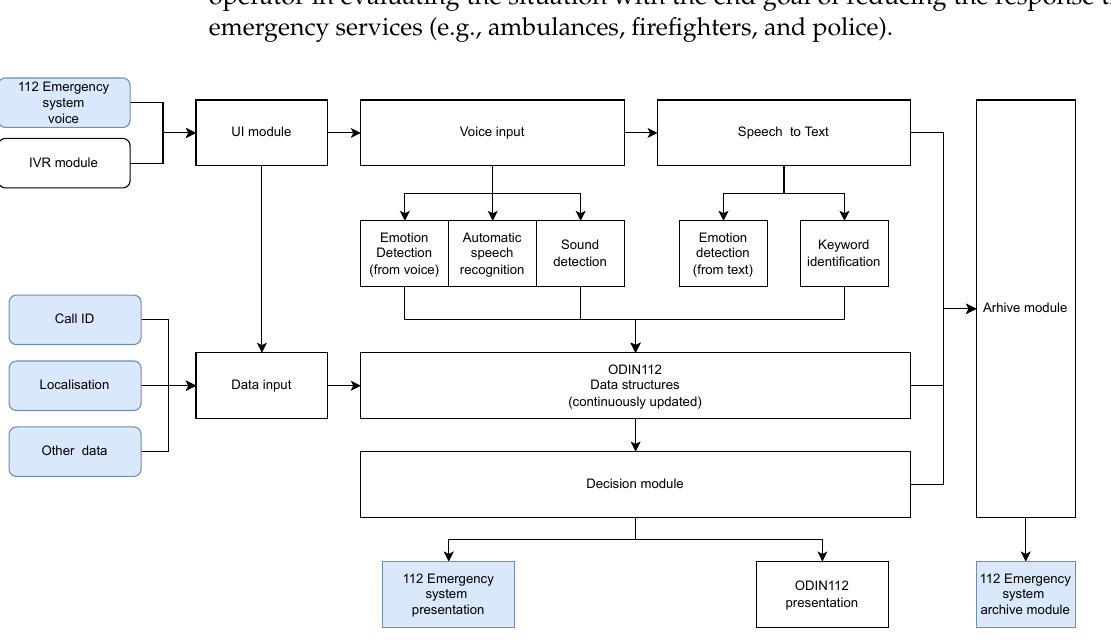
Figure 4. ODIN112 Architecture: Functional Components (the existing emergency services system components are represented in